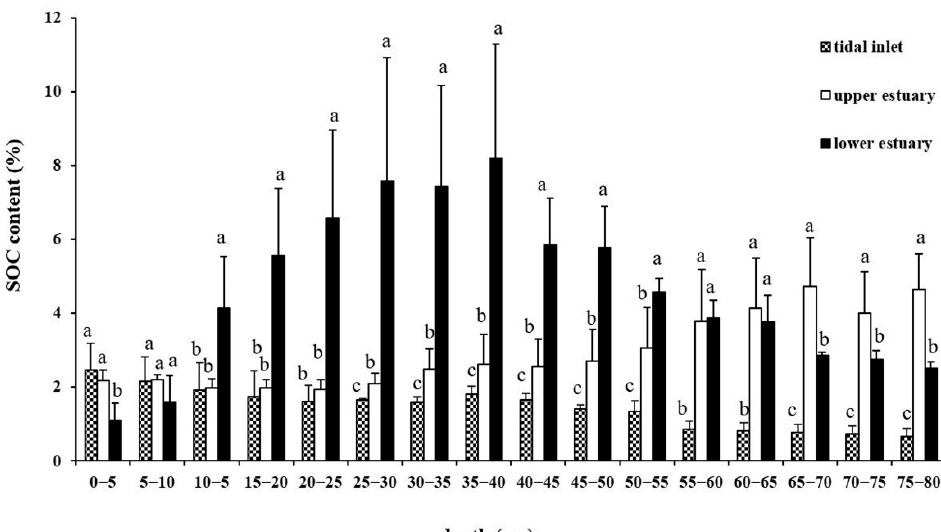
Figure 2. SOC content of different soil layers in three geomorphologic settings. Different lowercase letters indicate significances among sites at the same soil layer ( p < 0.05).